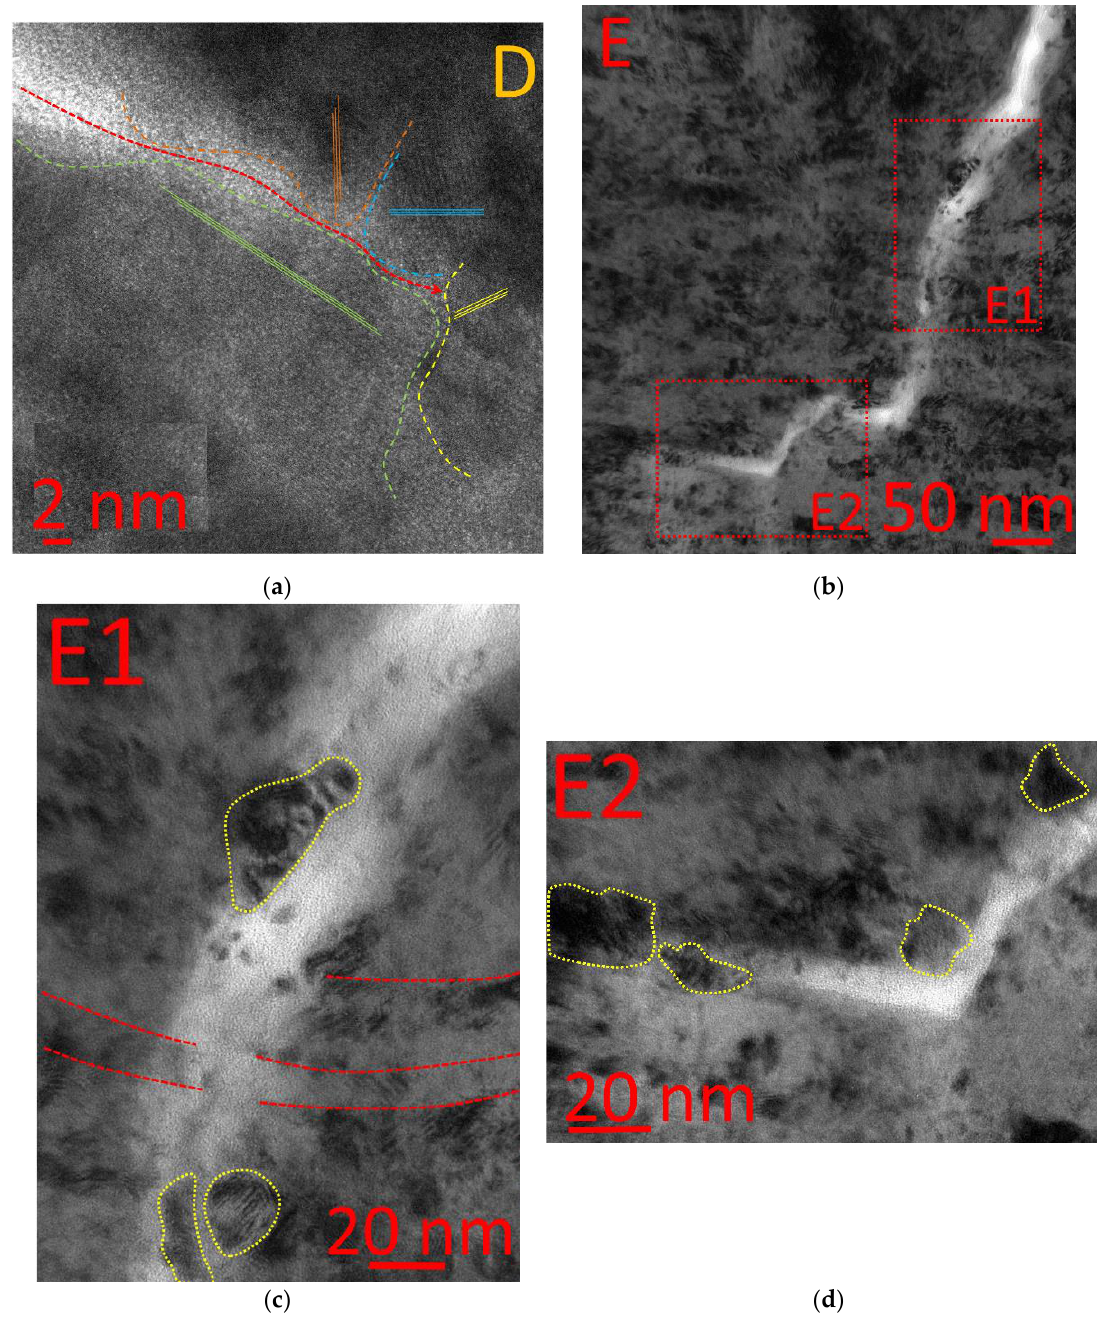
Figure 9. Pattern of crack Propagation through the structure of the nanolayer coating. ( a ) general view of Area D ( b ) general view of Area E, ( c ) Area E1, ( d ) Area E2.